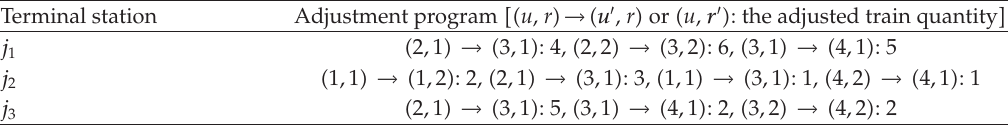
Table 5: Adjustment the scheme of passenger trains.